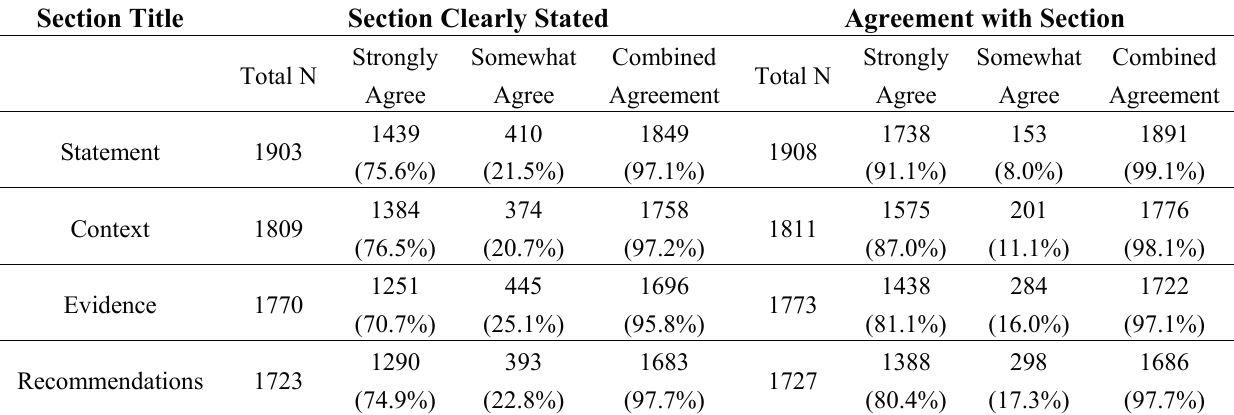
Table 3. Stakeholder assessment of the Position Statement’s clarity and stakeholder level of agreement, by